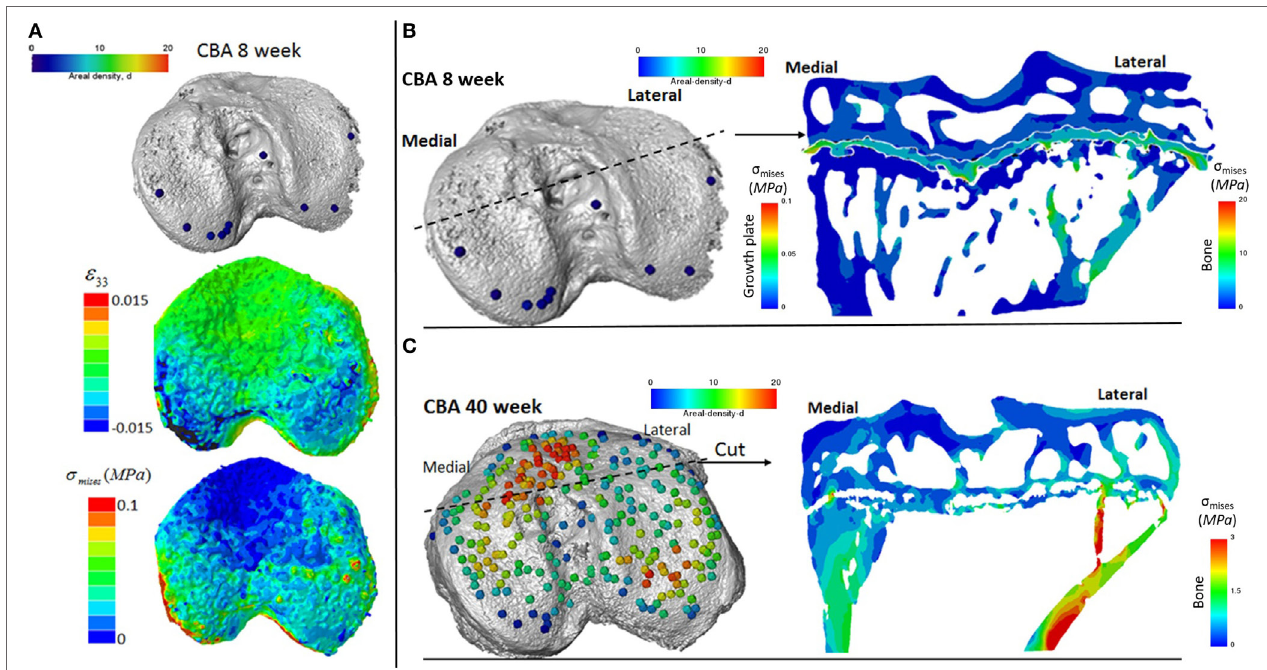
FigUre 5 | Finite element models of the loaded tibia in CBA wild-type mice (a) visualization of von Mises stresses on the tibial joint plateau. Visualization of the stresses associated with growth plate bridging in a coronal section of the tibia for a (B) young (8 week) and (c) mature (40 week) mouse